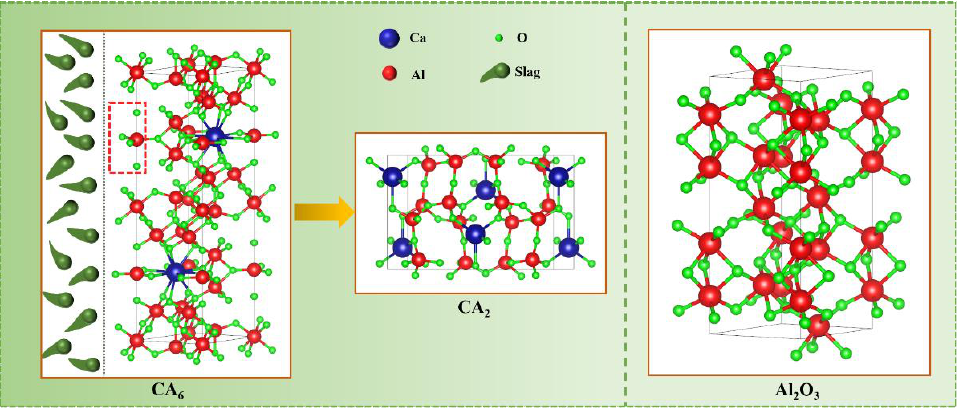
Figure 11. The crystal structure of CA 6 , CA 2, and Al 2 O 3